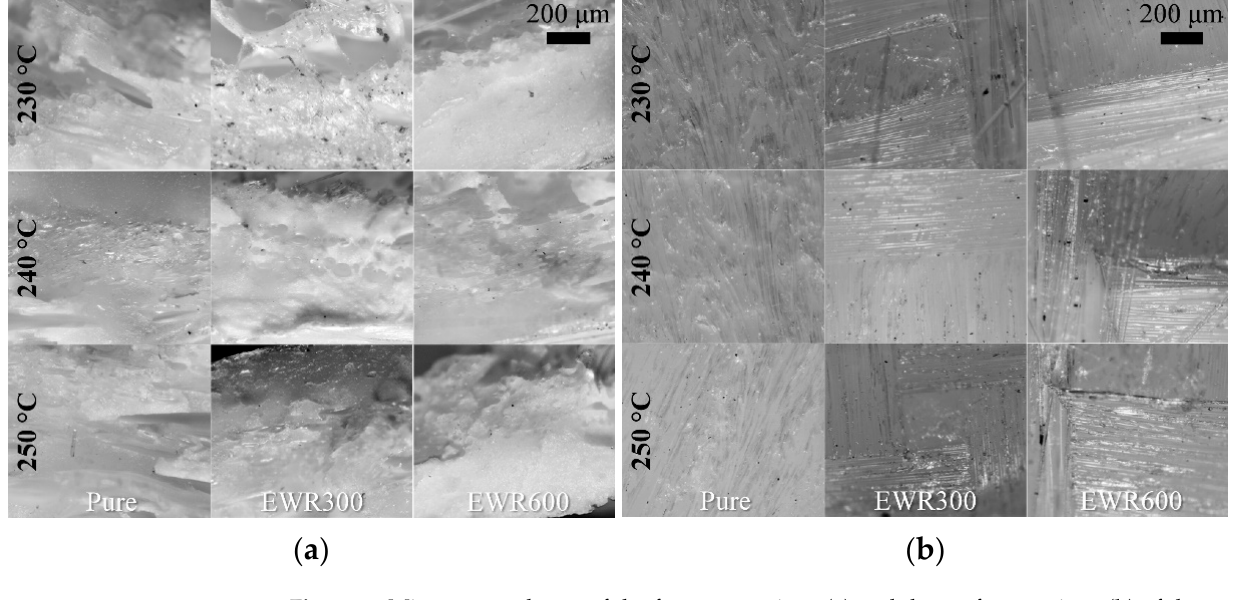
Figure 8. Microscopy photos of the fracture sections ( a ) and the surface sections ( b ) of the tensile samples with foaming.